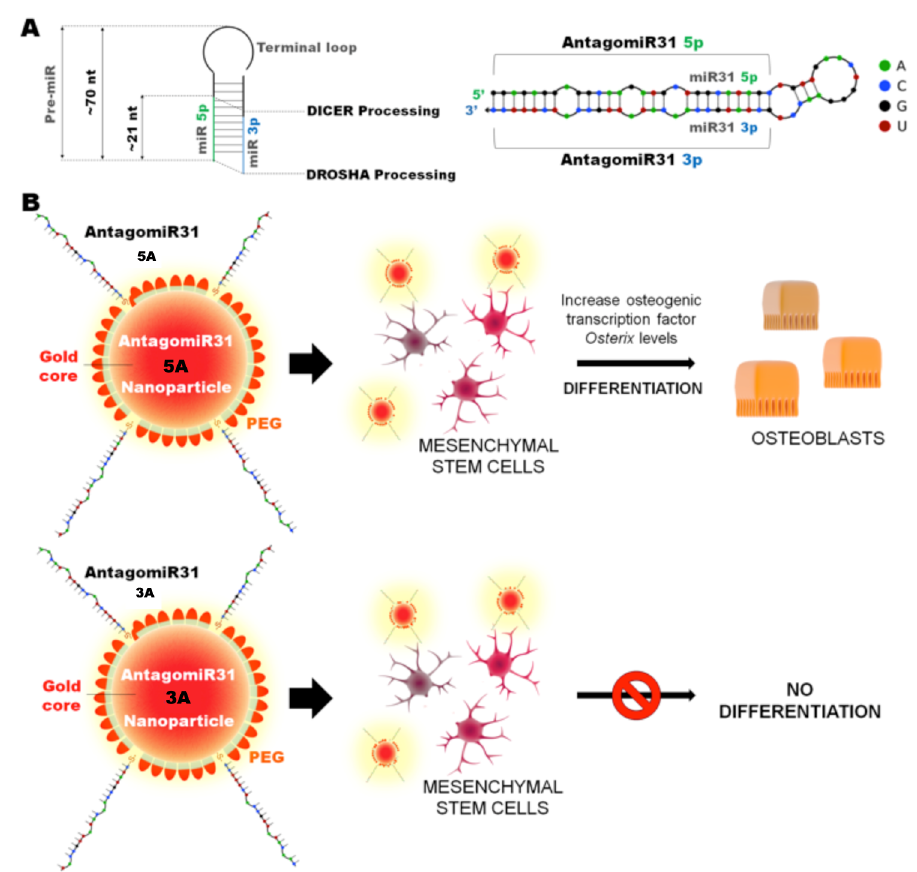
Fig 1. Overview of AntagomiR31 design, conjugation with nanoparticles and effect on cells. Schematic summary indicating (A) the 5’ and 3’ (5A and 3A) antagomiR design, prior to GNP functionalization, and (B) the sequence of events following incubation with mesenchymal stem cells. Note that only the 5A GNPs increased osterix expression and induced osteogenesis.